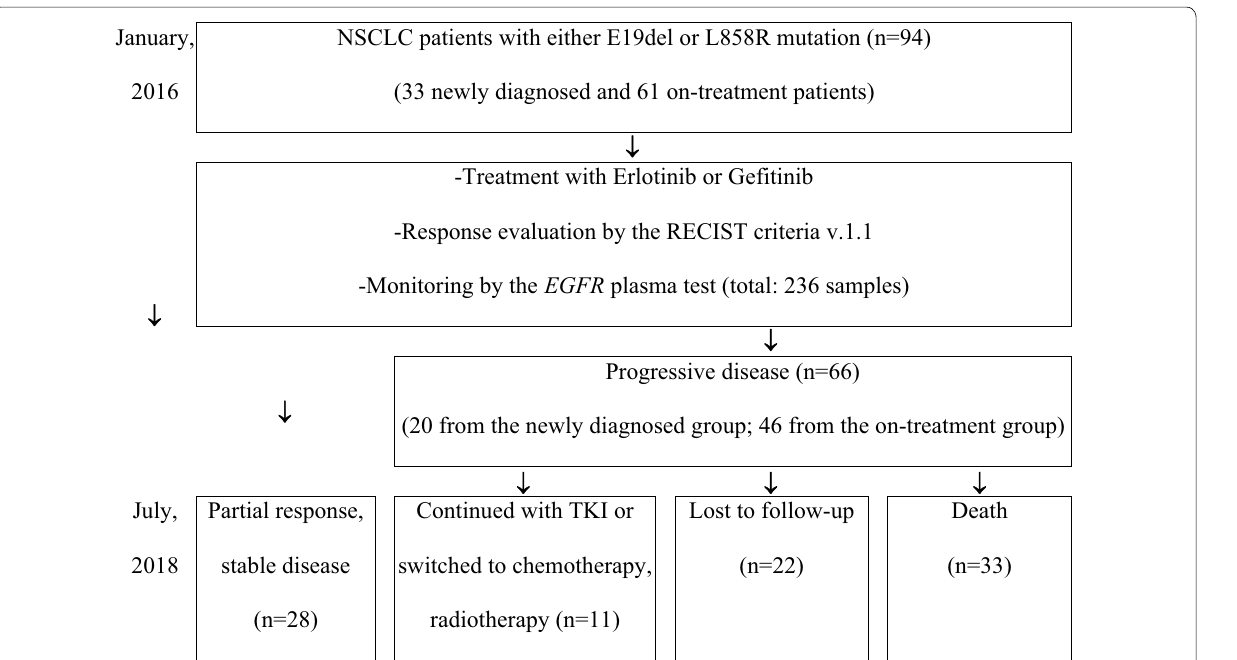
Fig. 1 Patient groups and analysis